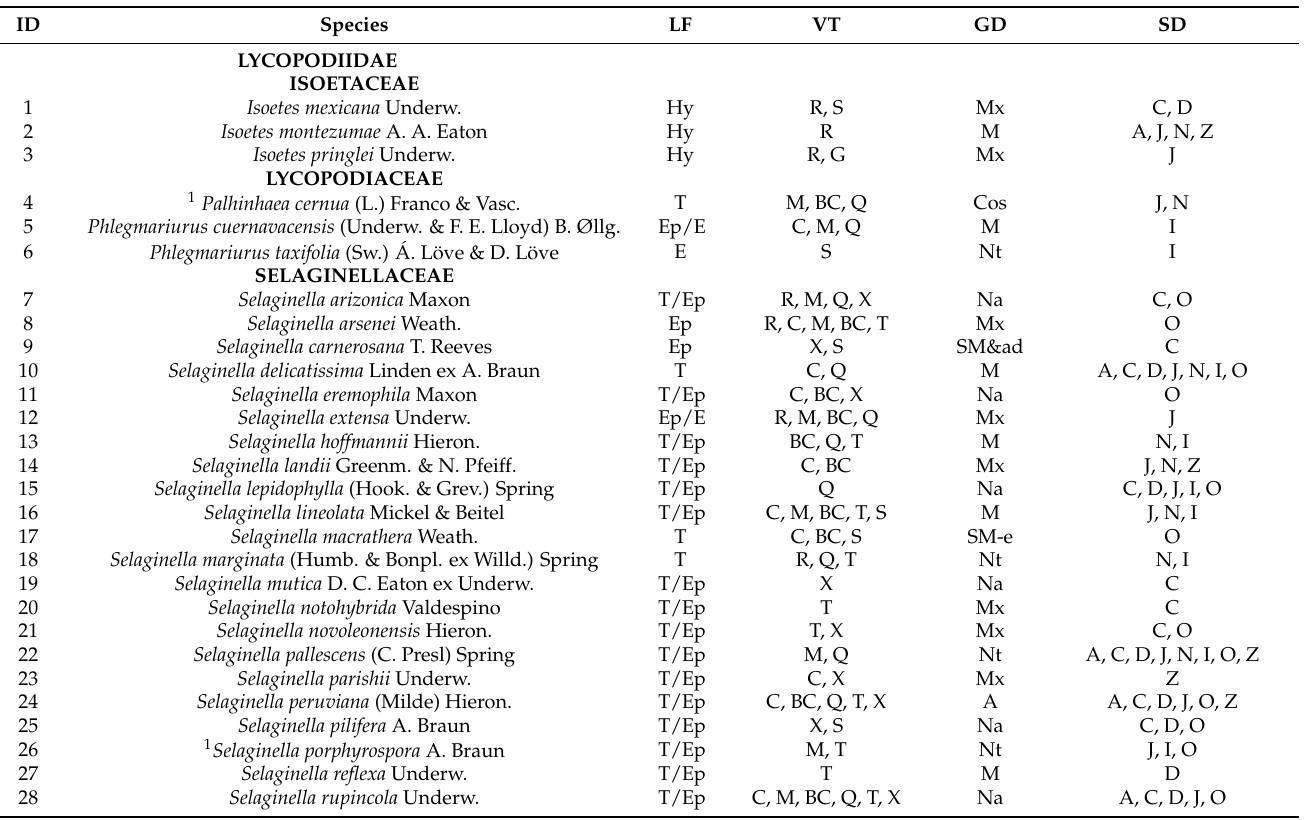
Table A1. Floristic checklist of ferns and lycophytes from the